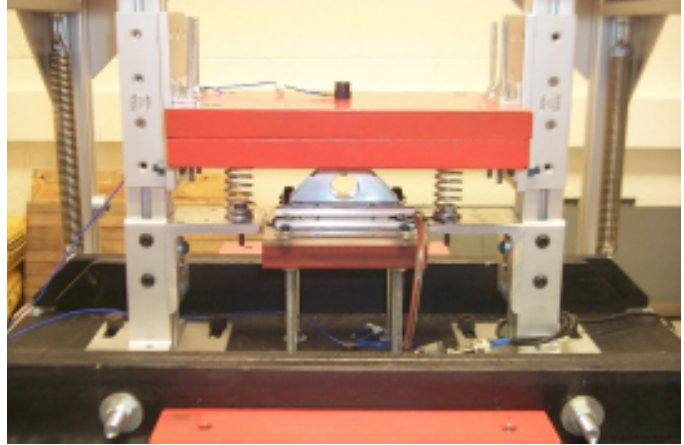
Fig. 11. Dead mass setup on test stand.